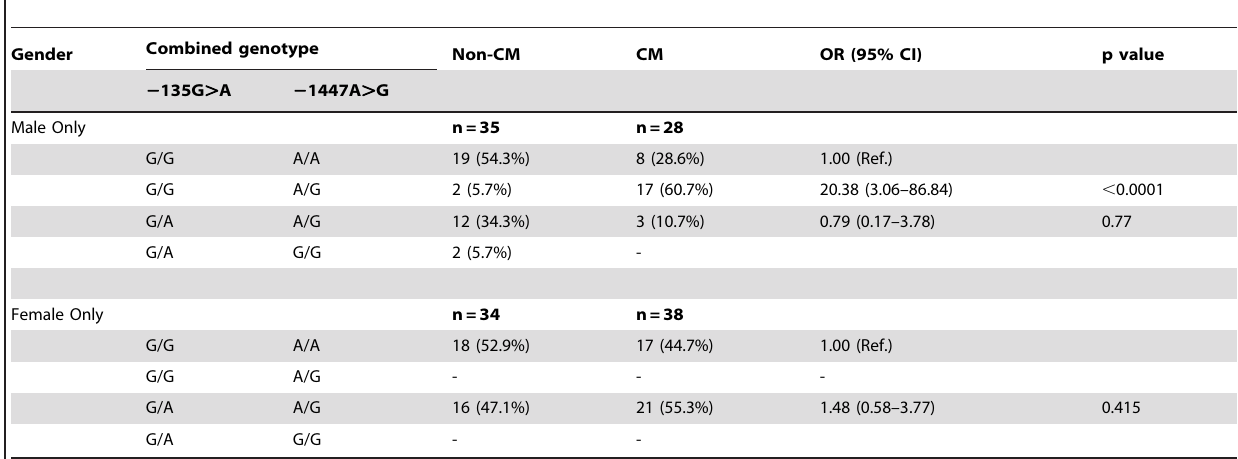
Table 6. Stratification analysis of combined genotype frequencies of CXCL10 polymorphisms in patients with cerebral malaria and non-cerebral